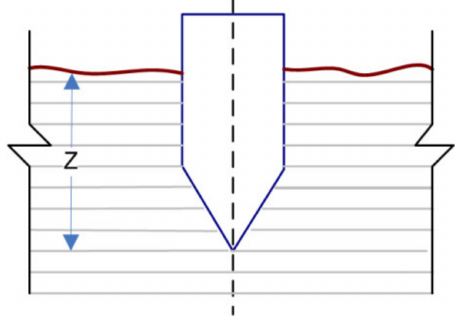
Figure 5. Model of Orthogonal Layers or